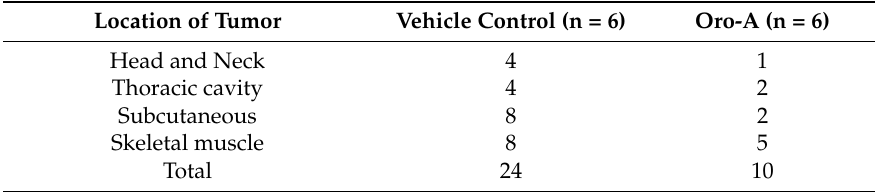
Figure 9. The human CCL2 levels in mice were determined with an ELISA. P values were determined using Student’s t test. Table 3. Summary of the number of colonization sites outside the lung in mice injected via the tail vein with IFIT2-depleted metastatic OSCC cells and treated with vehicle control or